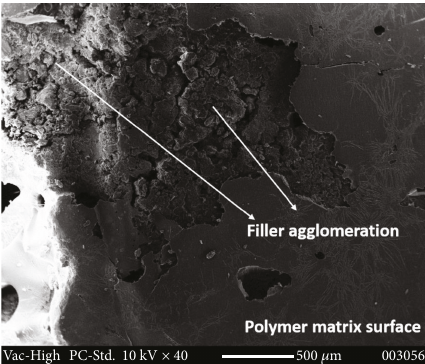
Figure 1: SEM of 10-DPP composite.